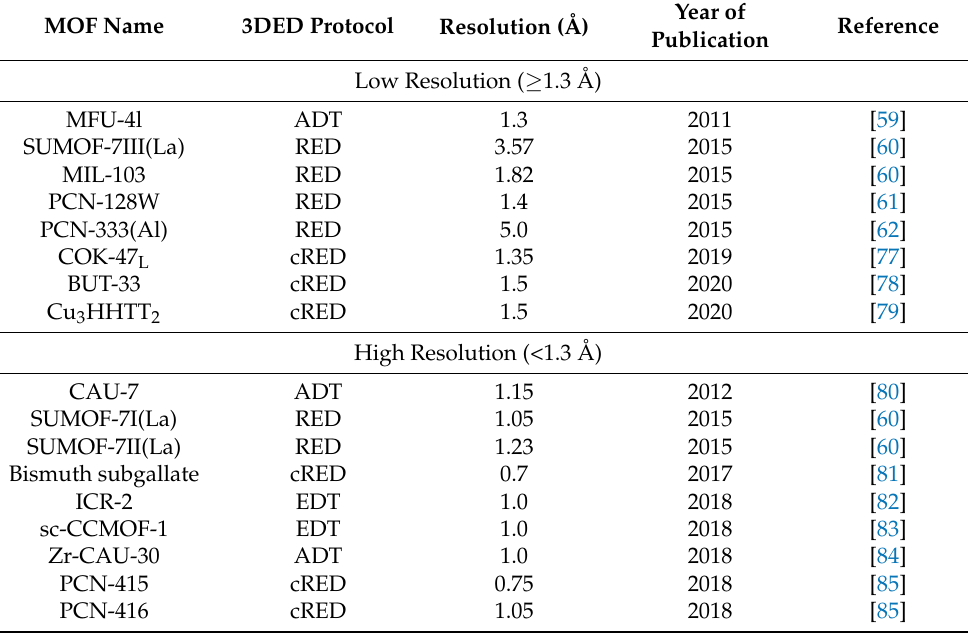
Table 1. List of selected metal-organic framework (MOF) structures determined using 3DED.